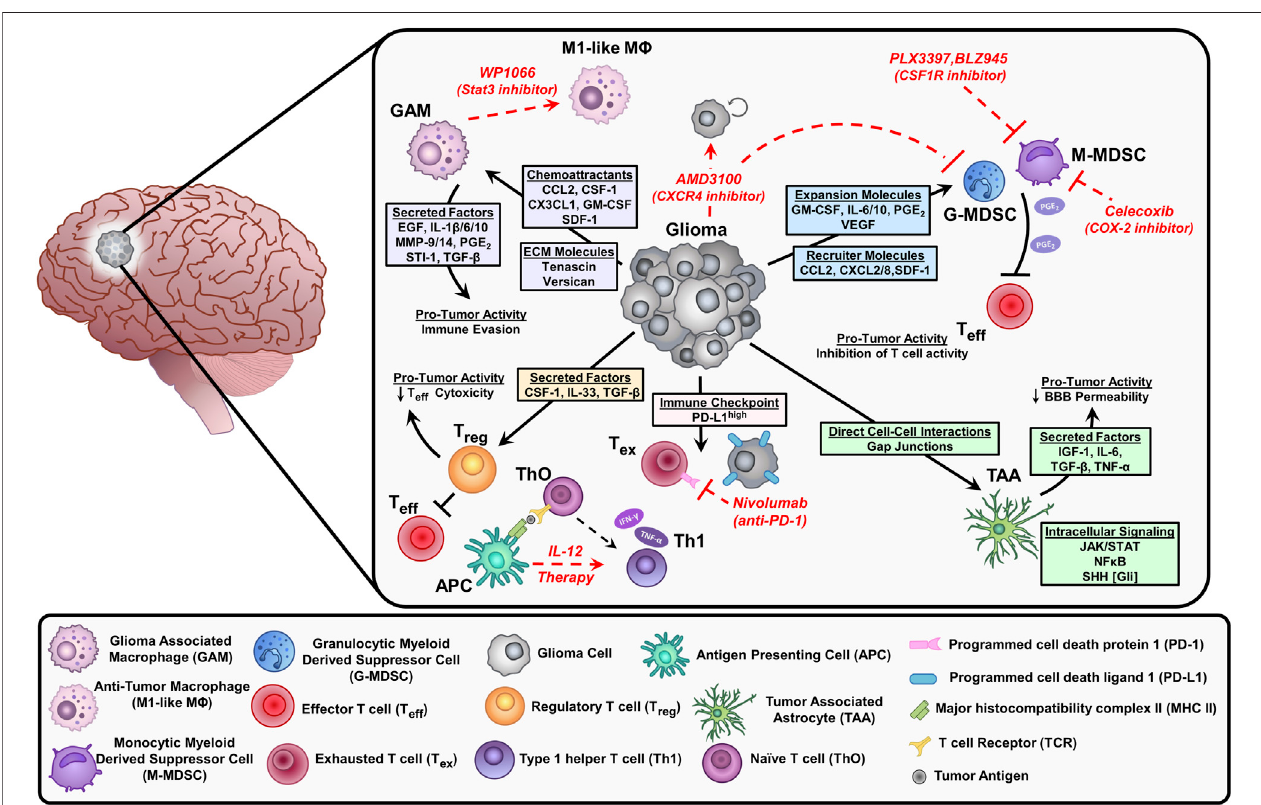
FIGURE2| Depictionoftheimmunosuppressiveenvironmentinglioblastomaandcurrenttherapeuticapproaches(red)tostimulateanti-tumorresponsesorinhibit suppressive immune cell populations. Glioma cells release chemoattractants and cytokines that recruit immune cells into the tumor microenvironment (TME). These factors elicit pro-tumor activities that inhibit effector T cells (Teff) and contribute to tumor progression. Glioma cells can also directly interact with immune cells and astrocytes impacting the effectiveness of chemotherapy. Inhibition of Stat3 by WP1066 reduces glioma-associated macrophages (GAM) by blocking intracellular signalsinducedbyIL-10topromote ananti-tumor macrophage(M1-likeM Φ ) phenotype. TheCXCR4 antagonist AMD3100preventsthebinding ofstromalcell-derived factor (SDF-1), resulting in decreased tumor proliferation and blocks the migration of myeloid-derived suppressor cells (MDSCs) in the TME. The CSF1R inhibitors (PLX3397, BLZ945) suppress the in fi ltration of myeloid cells (macrophages and MDSCs) within the TME. MDSCs synthesize prostaglandin E2 (PGE2) via COX-2 which inhibitseffectorTcellsbyreducingInterferon-gamma(IFN- γ )release.TheCOX-2inhibitor,celecoxibreducesMDSCimmunosuppressiveactivity.Interleukin-12(IL-12)is secretedbyantigen-presenting cells(APC) like dendritic cells and macrophages, exogenousIL-12therapytriggersapro-in fl ammatorytransition ofnaïve Tcells(ThO)to type 1 helper T cells (Th1) leading to an increase in IFN-y and tumor necrosis factor (TNF- α ) secretion. Tumor cells express high levels of programmed cell death ligand (PD-L1) on their cell surface, which leads to exhausted T cells (Tex) by immune checkpoint signaling through their receptor programmed cell death protein 1 (PD-1). Inhibition of PD-1 with nivolumab reduces T cell exhaustion.